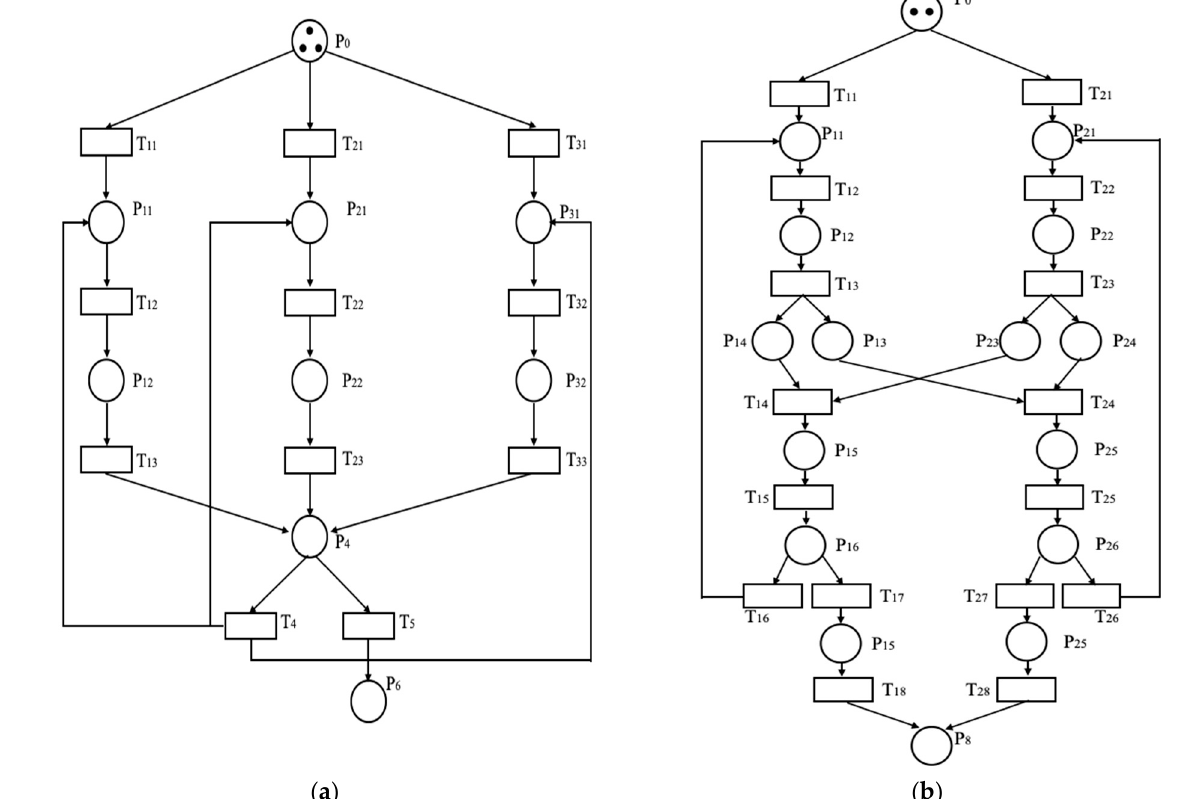
Figure 2. The Petri net of the attack/reconnaissance process. ( a ) Petri net of the coordinated attack process. ( b ) Petri net of the coordinated reconnaissance process.